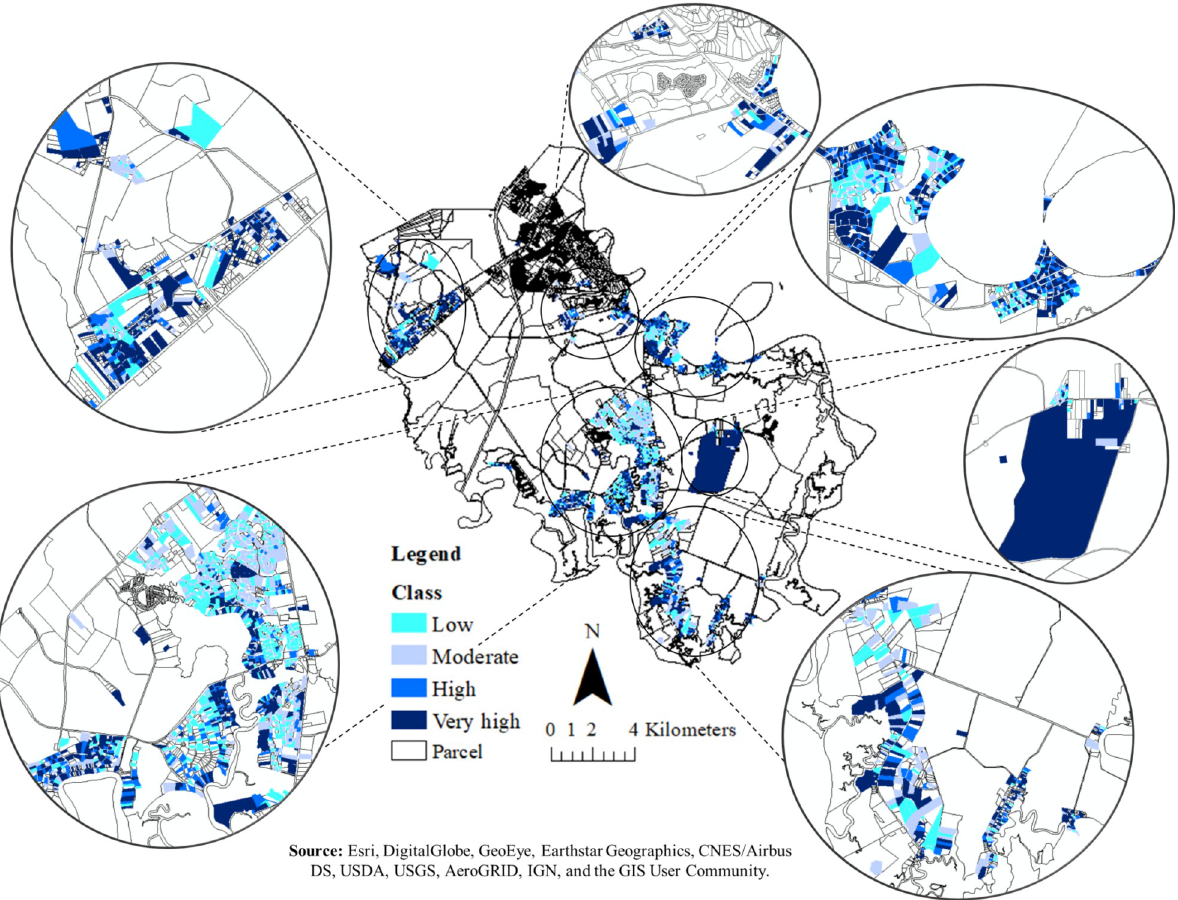
Fig 10. Classification of septic system replacement rate for the southern part of the Bryan County using classification inference tree and logistic regression.